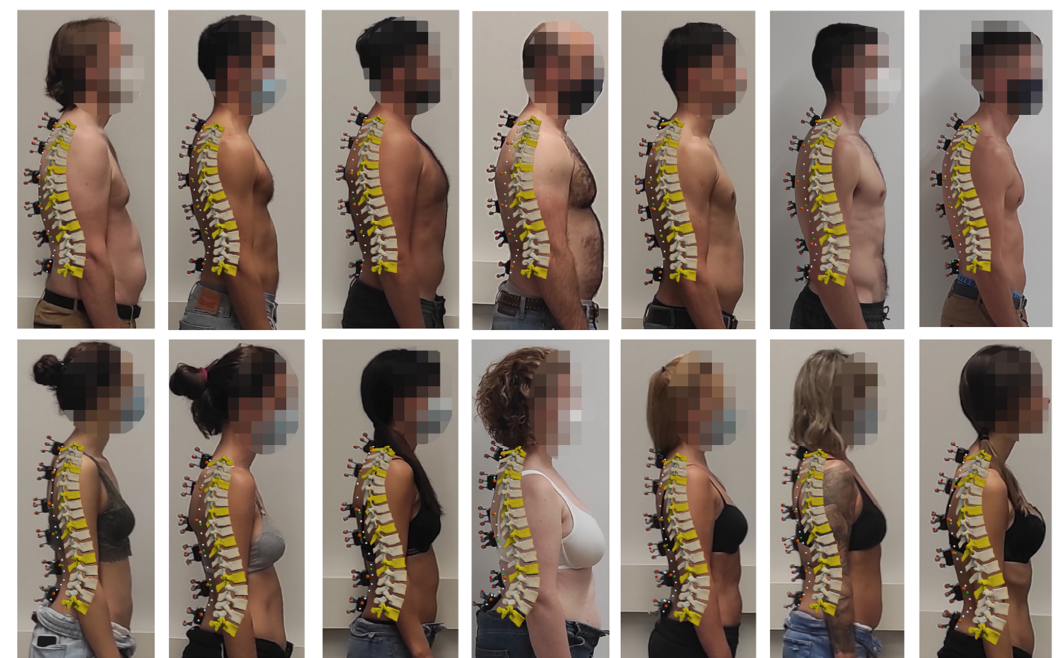
Figure 8. Lateral view of the fourteen 3D models obtained with TPM-OPT and six sensors.